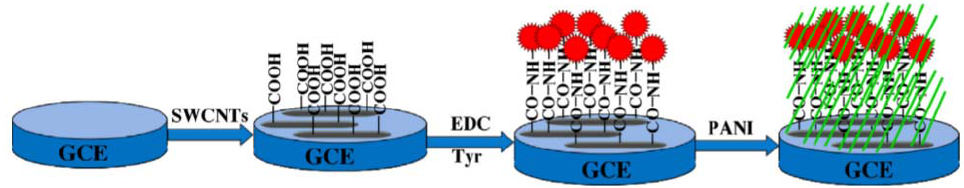
Figure 4. The sandwich structure of the biosensor PANI/Tyr ‐ SWCNTs/GCE [95]. Reprinted with the permission of the publisher.